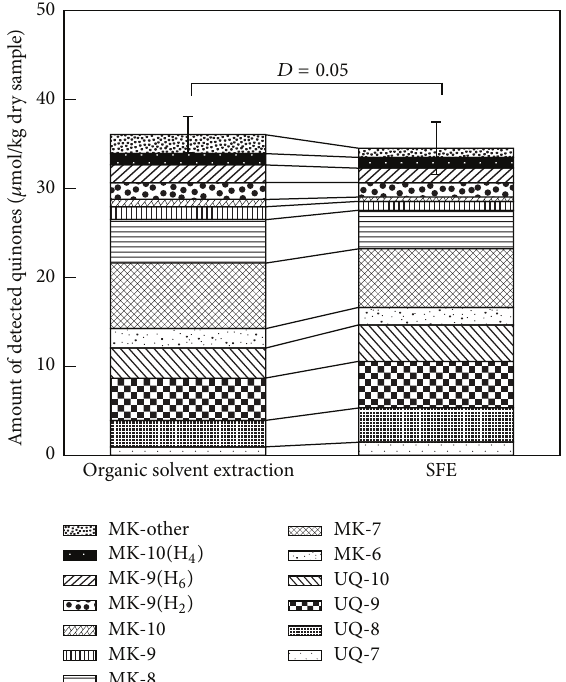
Figure 5: Comparisons of quinone profile between the SFE and organic solvent extraction methods. Sample: 0.3 g dry compost of food waste and wood chips for both methods. Organic solvent extraction conditions: chloroform: methanol = 2: 1 (20 mL); 15 h. SFE conditions: 25 MPa; 90% CO 2 -10% methanol, flow rate of 3 mLmin −1 ; 45 ∘ C; 30 min; number of samples examined =